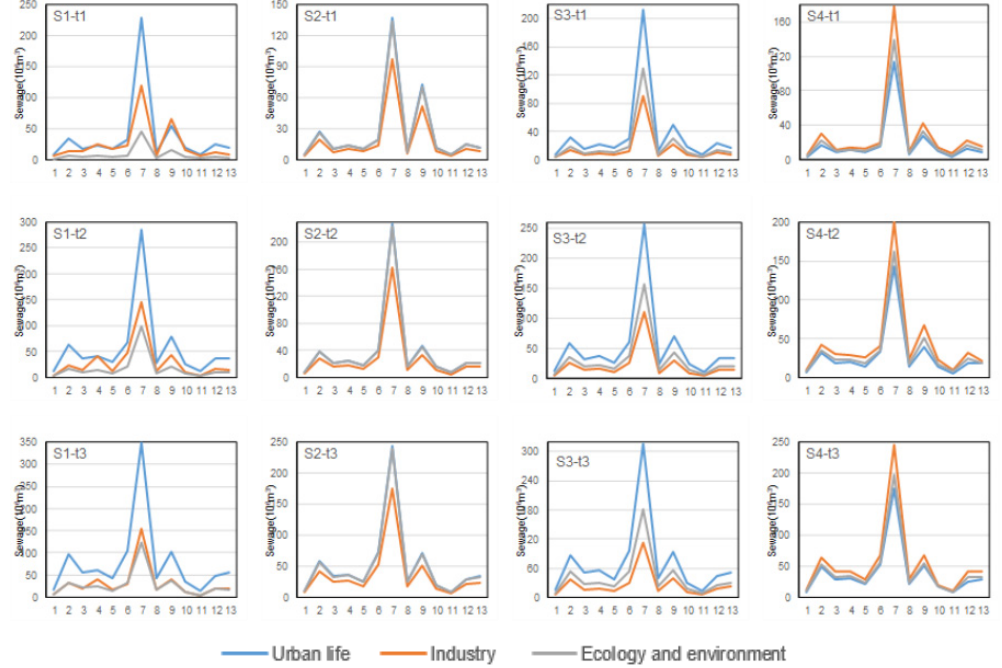
Figure 6. Amounts of sewage discharge under di ff erent scenarios in di ff erent departments and di ff erent periods (10 6 m 3 ). Note: S1, Scenario 1; S2, Scenario 2; S3, Scenario 3; S4, Scenario 4; t1, period 1;